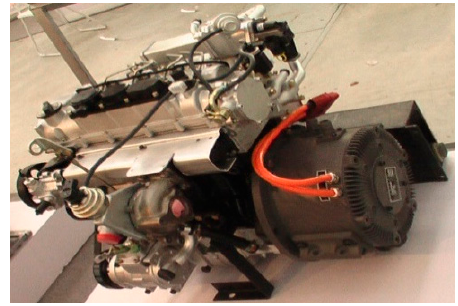
Figure 29. Experimental platform of PMSG-IDOS .